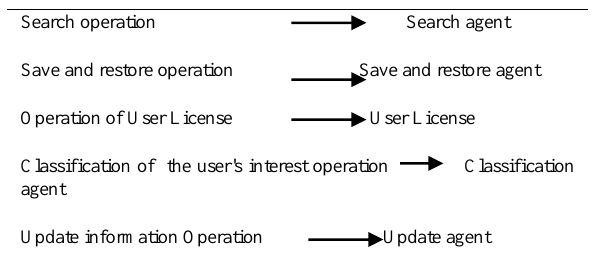
Table 12. Allocation of roles to